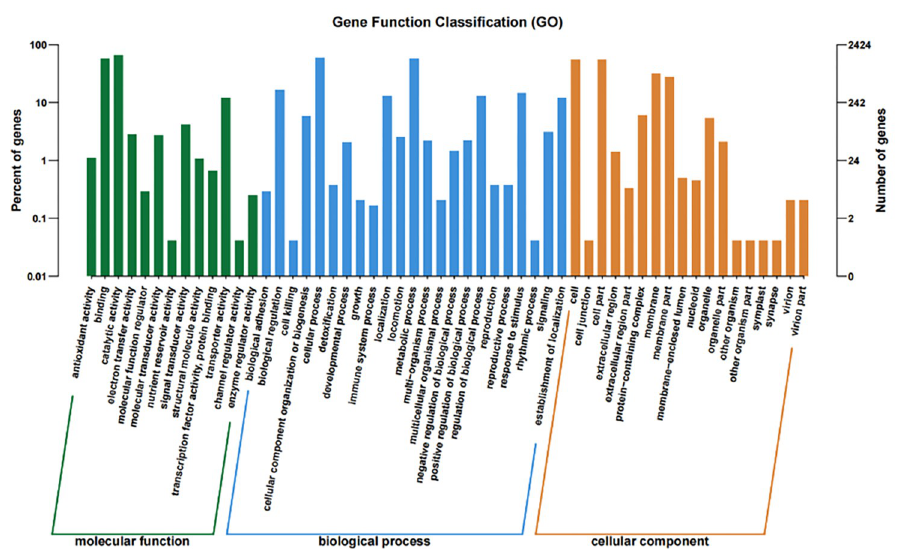
Fig 1. GO enrichment analysis of unigenes. The X-axis showed GO function. The right Y-axis showed number of genes, and the left Y-axis showed the percentage.